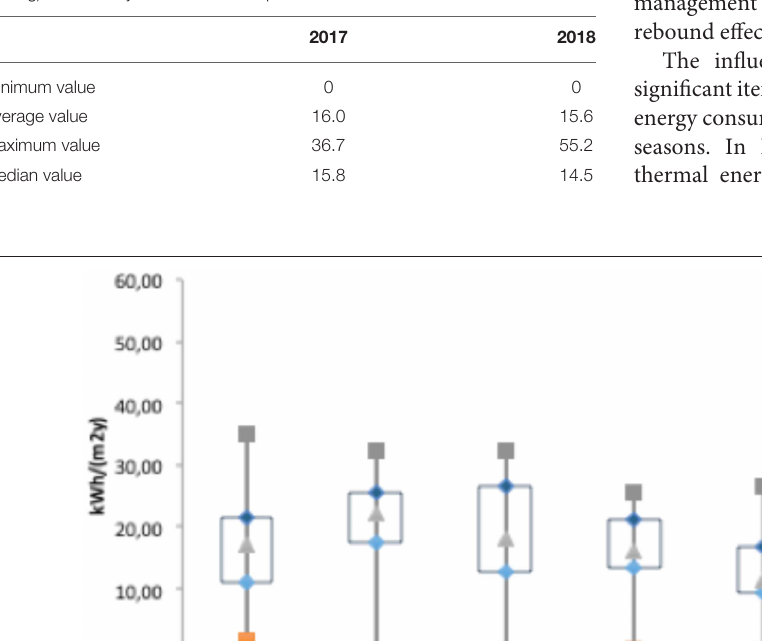
TABLE 5 | Synthesis of the measured data (thermal energy consumption for cooling) in kWh/m 2 y for the total occupied flats.